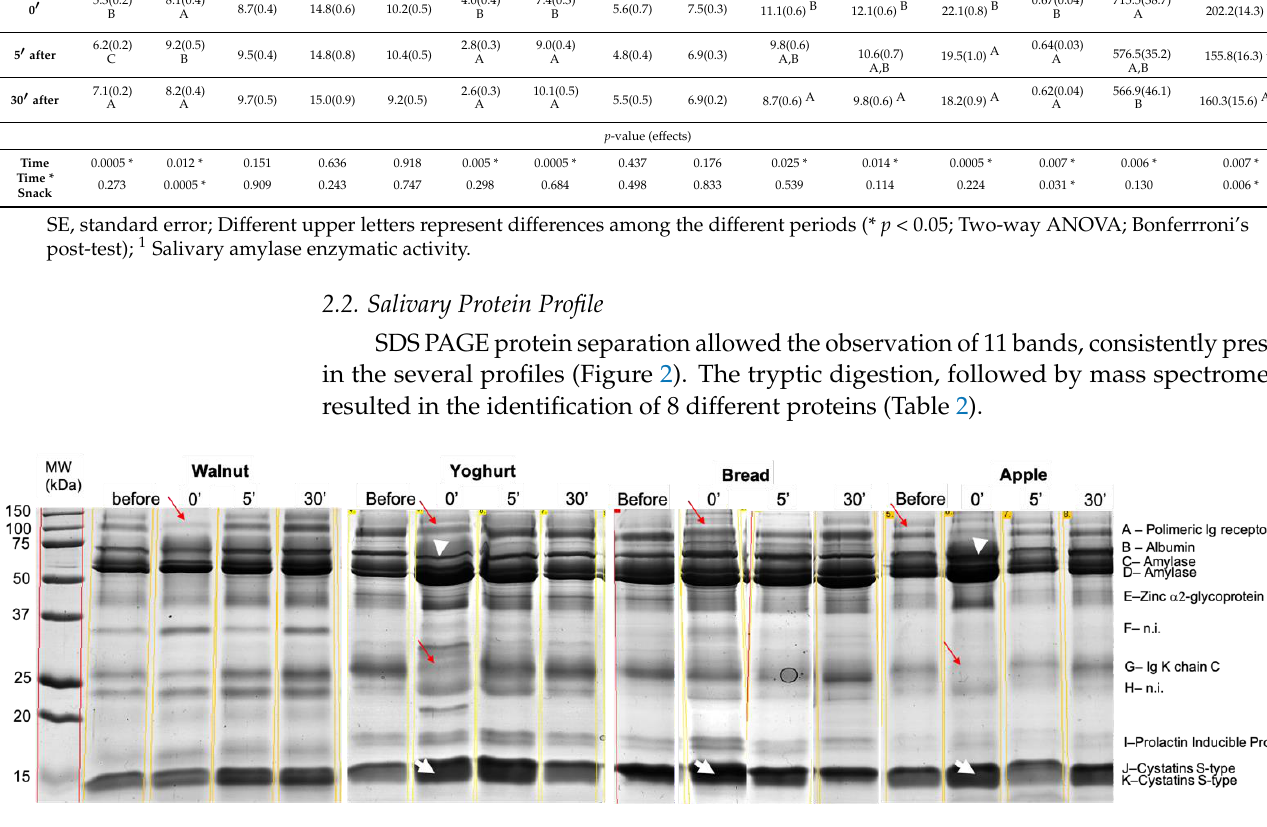
Figure 2. SDS-PAGE profiles representative of saliva collected before and after the ingestion of the four snacks studied. Bands A and G decreased immediately after ingestion (0’) of snacks (red arrow); Band B decreased immediately after yoghurt and increased immediately after apple intake (white arrowhead); Bands J + K increased immediately after the intake of all foods except walnuts (white arrows).